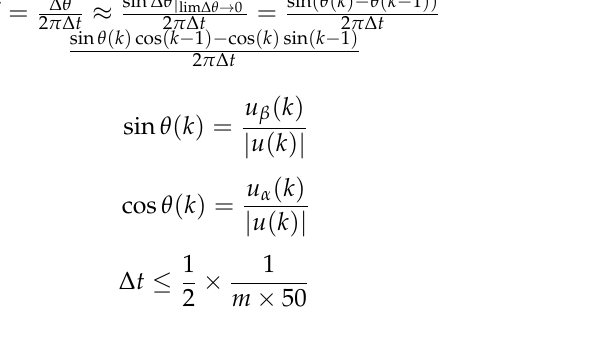
Figure 4. Rotation vector diagram of grid side voltage at adjacent sampling times.